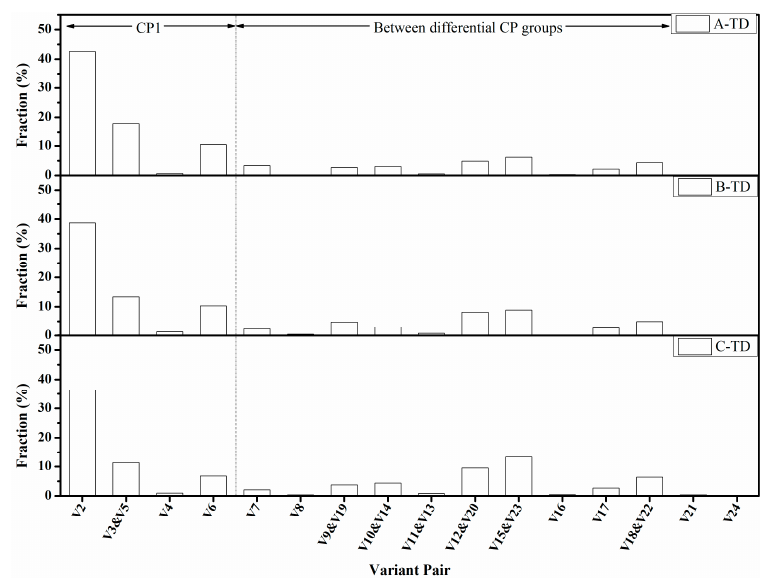
Figure 13. The fraction of the variant pairs constituting the angle boundaries in these specimens in the transverse direction.